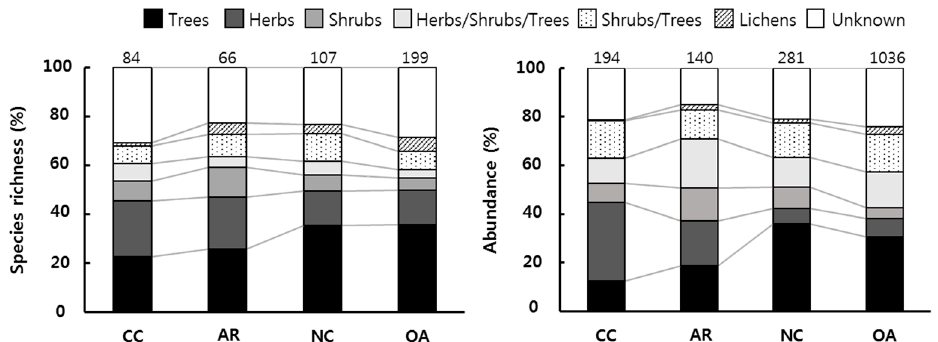
Figure 4. Proportion of species richness and abundance of the functional groups based on the type of host plants. The numbers on the bar indicate species richness (number of species) and abundance (number of individuals) in the corresponding treatment. CC: clearcutting area; AR: aggregated retention area; NC: no cutting area; OA: Mongolian oak